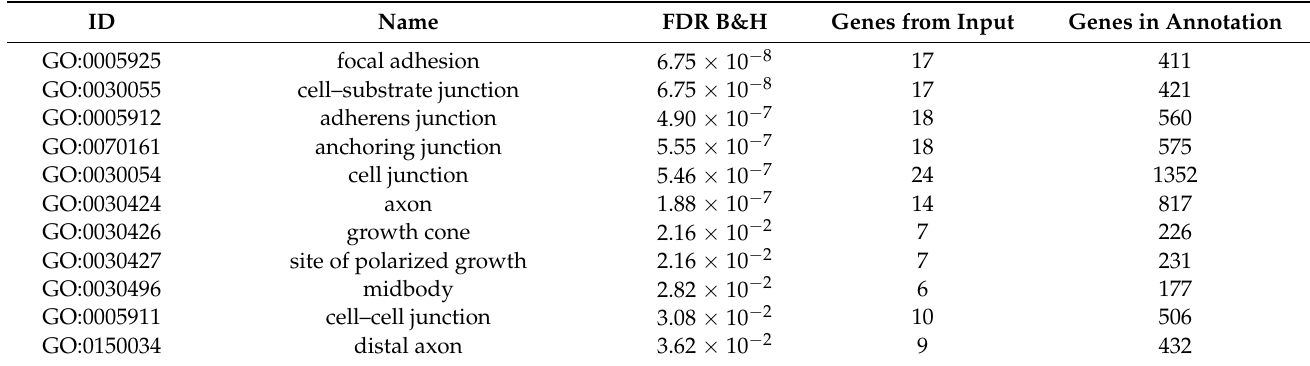
Table 4. Cellular components regulated by Activin-A in FOP